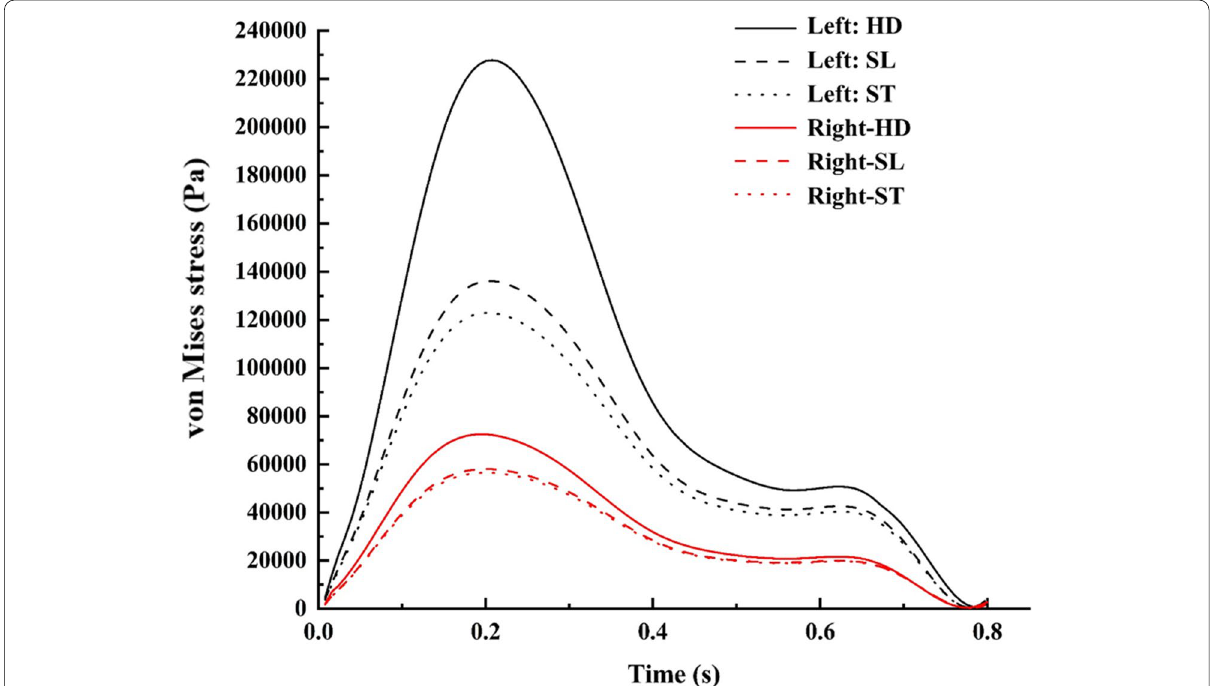
Fig. 15 von Mises stress comparison for various